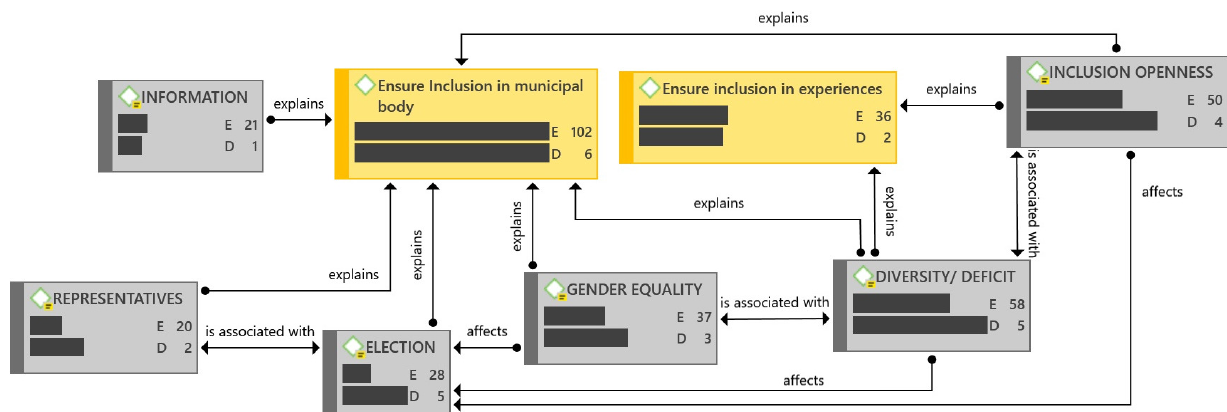
Figure 3. Categorial network (image generated by Atlas.ti 9). 52:1 Places are reserved for children with functional diversity and at risk of social